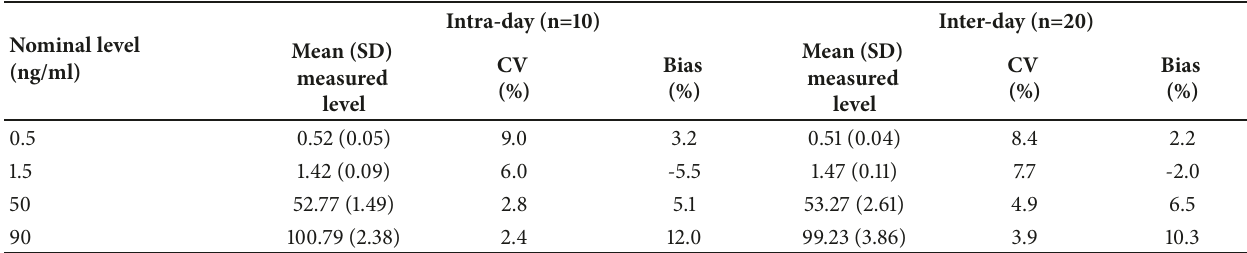
Table 2: Intra-and inter-run precision and accuracy of cortisol